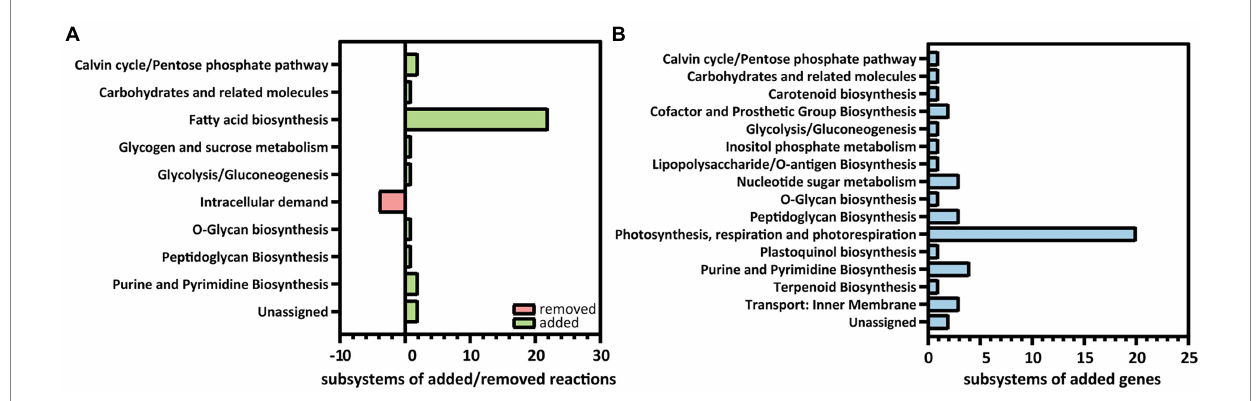
FIGURE 1 Distribution of reactions and genes added and removed to i MS837 based on functional subsystems. (A) Summary of reactions added and removed to i MS837. (B) Summary of genes added to i MS837. In both cases, the subsystems where changes have been made are only represented.